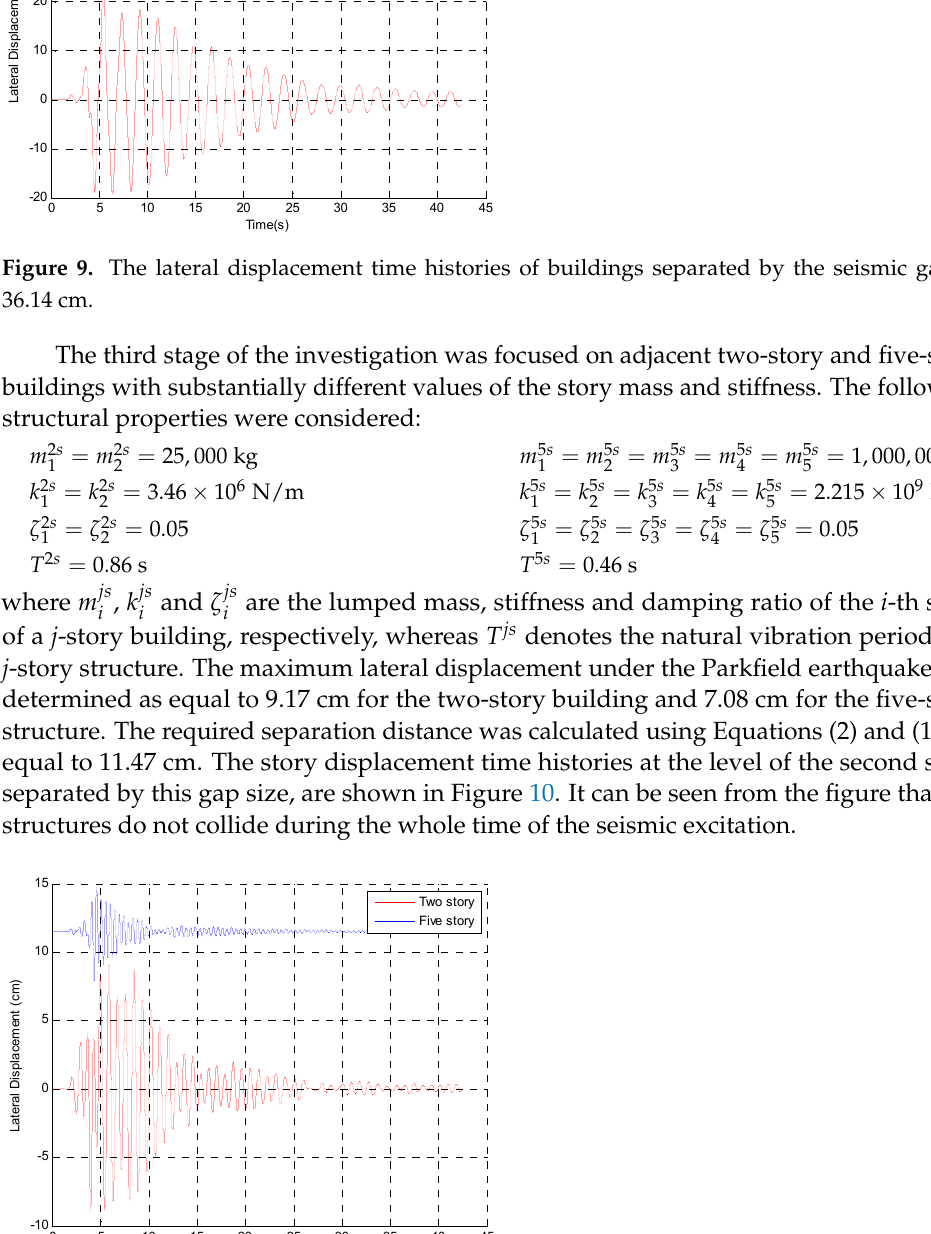
Figure 10. The lateral displacement time histories of two buildings separated by the seismic gap equal to 11.47 cm.